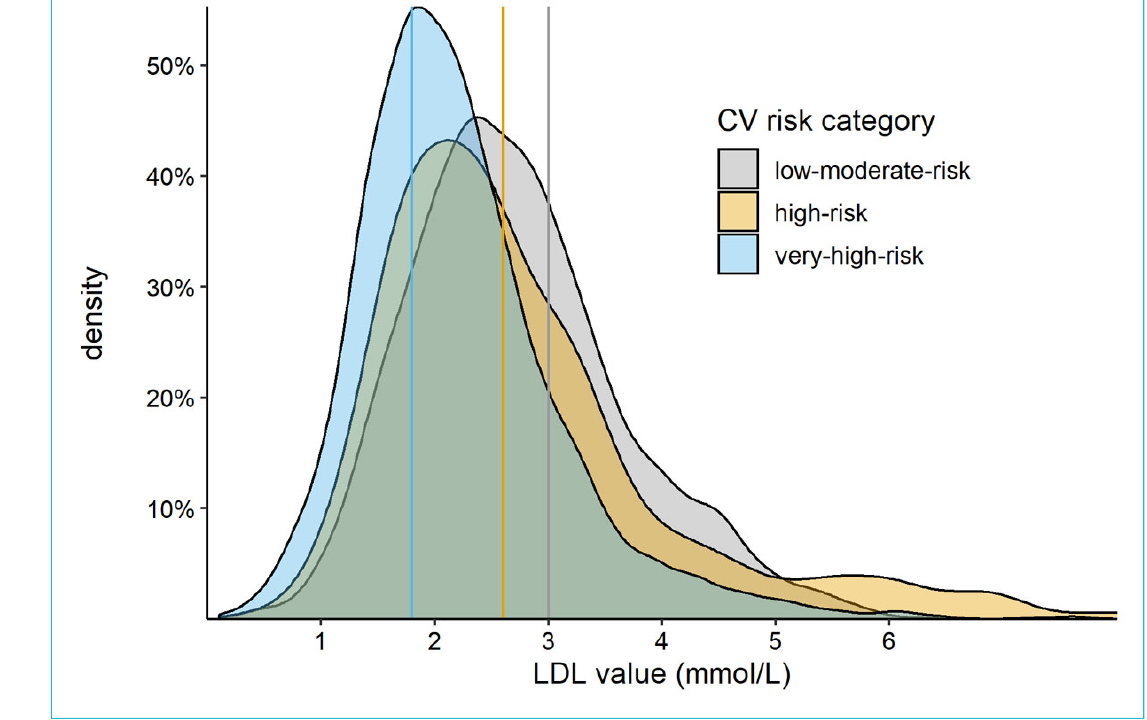
Figure 2: Distribution of patients’ LDL levels by cardiovascular risk. Areas under the curve represent all patients with a measurement (100%), the height of the curve represents the estimated percentage of patients with the corresponding LDL value (Kernel density estimation) for the different CV risk categories. Guideline recommended target values for the respective CV risk category (low/moderate <3.0 mmol/l, high <2.6 mmol/l, very high <1.8 mmol/l) are indicated by colour-coded vertical lines. Upper limit for data visualisation was 8